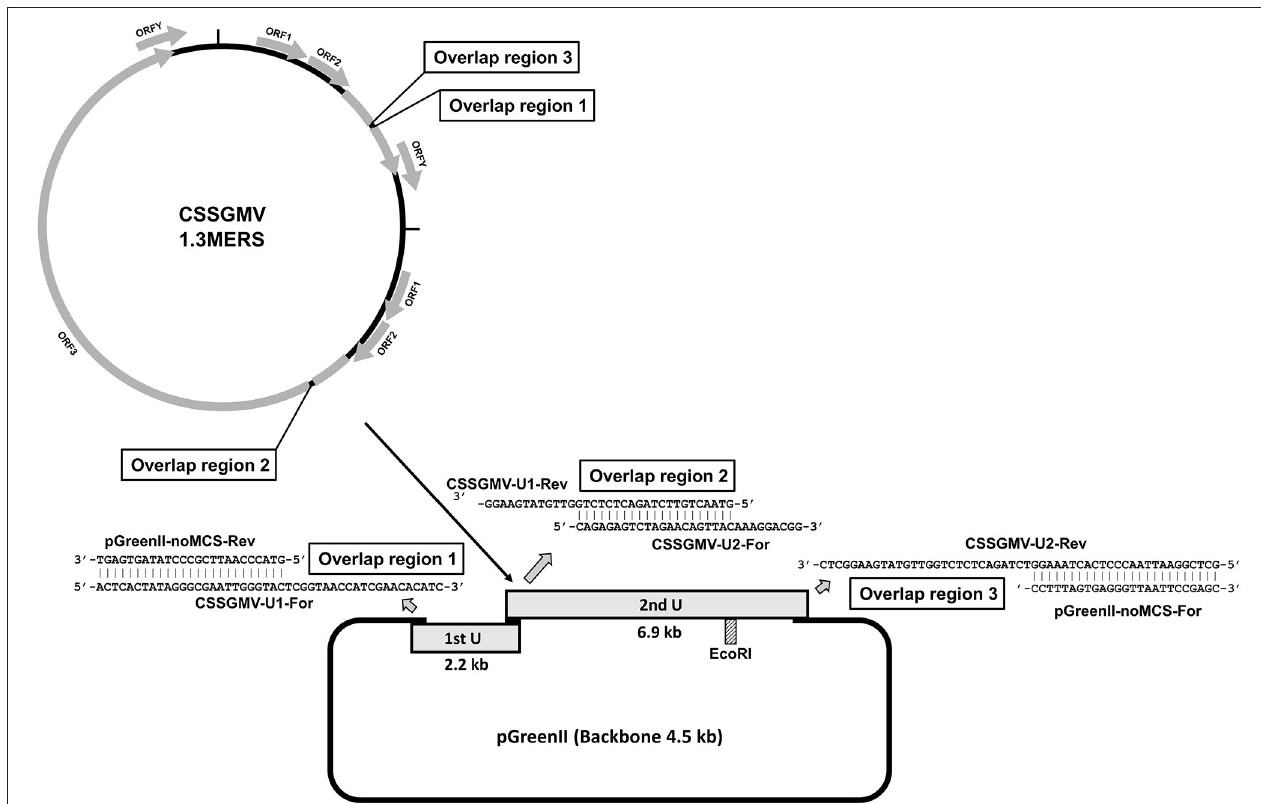
FIGURE 1 | Cacao swollen shoot Ghana M virus (CSSGMV) agroinfectious clone assembly. The first and second viral units are represented by gray rectangles, and the primer-pairs containing overlapping sequences by gray arrows. The EcoRI restriction site (dashed rectangle) was used to confirm 1.3 mers clones by endonuclease